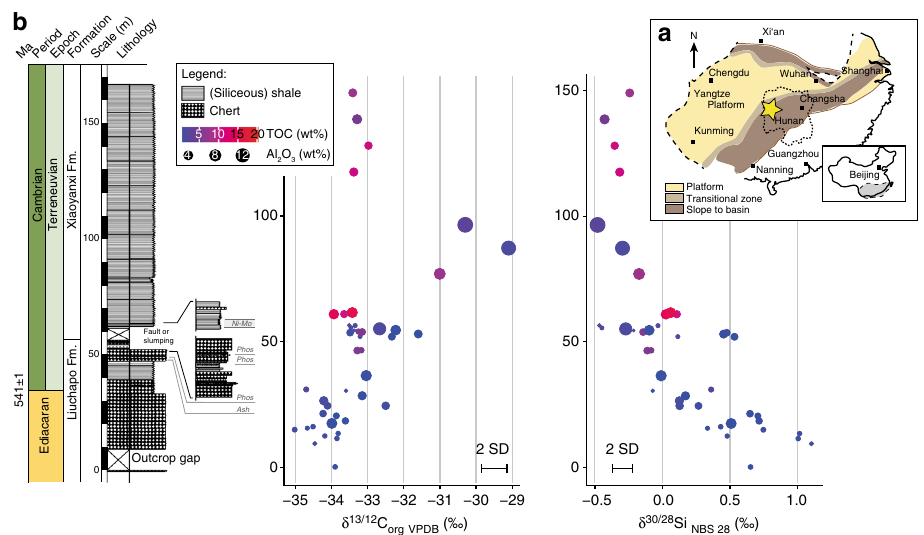
Fig. 1 Lithostratigraphic pro fi le of the Lijiatuo section and C- and Si stable isotope ratios of chert and siliceous shales and the paleogeographic setting of the site. The Lijiatuo section a is located in the continental slope-to-basin setting at the Yangtze Platform b and contains chert, siliceous shales and regional, Lower Cambrian marker horizons, i.e., phosphate bearing units (Phos) and a Ni-Mo layer as well as an ash layer (Ash) dated to 546 ± 12 Ma 26 . The sedimentary facies of the section changes towards higher TOC concentrations as shown by symbol colour ( blue : < 5 wt%, red : 15 wt%) as well as towards higher the clay-mineral contents (represented by the Al 2 O 3 concentration, increasing symbol size). Scale bar , 10